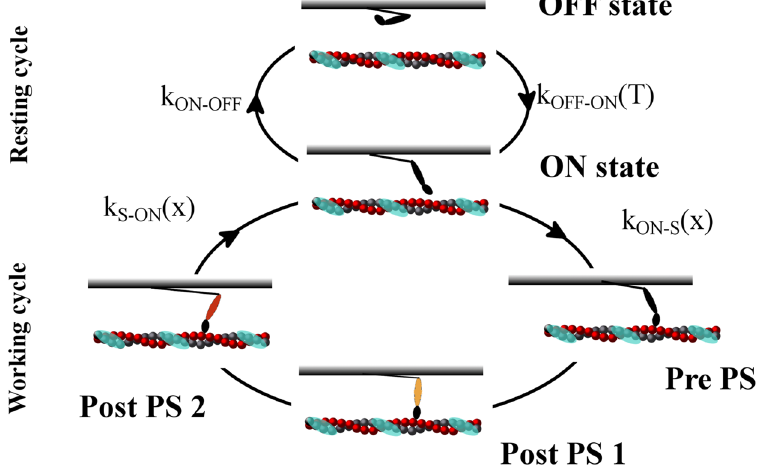
Figure 1. Two-cycle model. In the model, myosin motors can follow two cycles, a non-force-generating, “resting” cycle and a force-generating, “working” cycle, connected through one motor state. In the resting cycle, motors can lie along the thick filament in the OFF or super-relaxed state, or they can rise toward the thin filament, in the ON or active state, ready to enter into the working cycle. Motors in the ON state can use energy from ATP to generate active force. Myosin motors can then strongly attach to actin filament (shown with the periodic troponin-tropomyosin units in cyan) and perform a two-step power stroke. The rate constant from the OFF to ON state, k OFF–ON , is a function of the tension, T, acting on the thick filaments, indicating a mechanosensing mechanism, while k ON–OFF is a constant. Rate constants for strong attachment (k ON–S ) and detachment (k S–ON ) are functions of the axial position of each motor, with respect its relaxed state, as in the original Huxley 1957 model 35